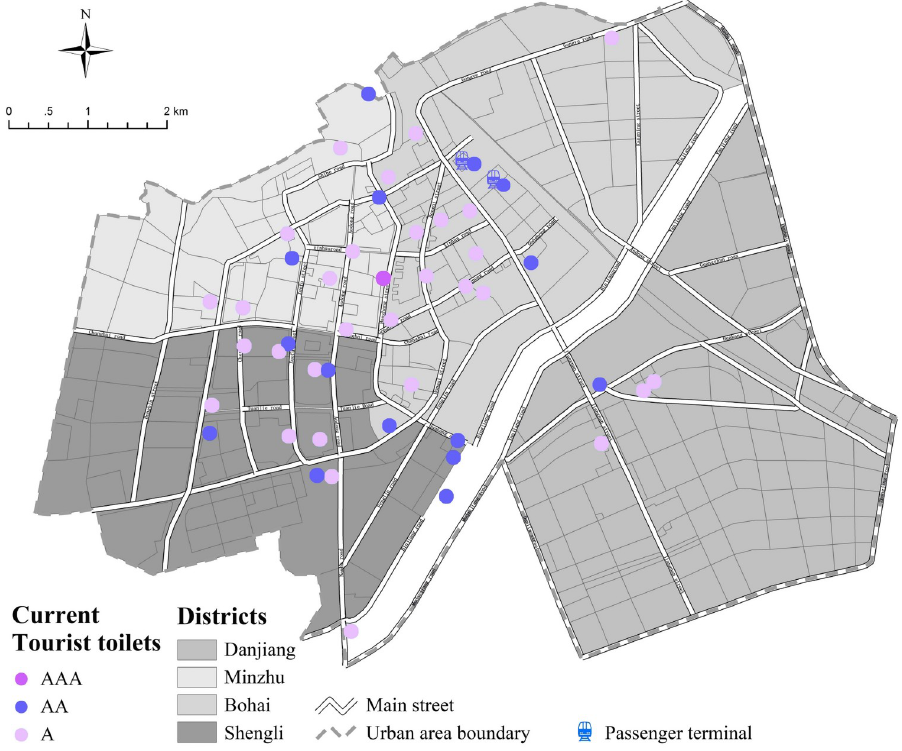
Fig 5. Layout of current toilets in each districts of urban area (copyright hold by the